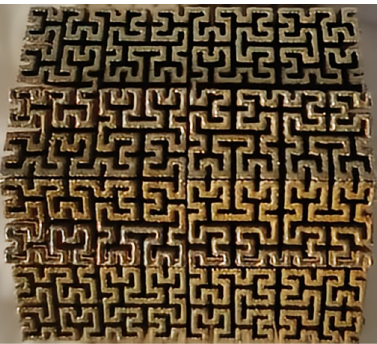
Figure 5. 3D ‐ printed hollow iron core designed upon a Hilbert curve geometry [27]. Figure 5. 3D-printed hollow iron core designed upon a Hilbert curve geometry